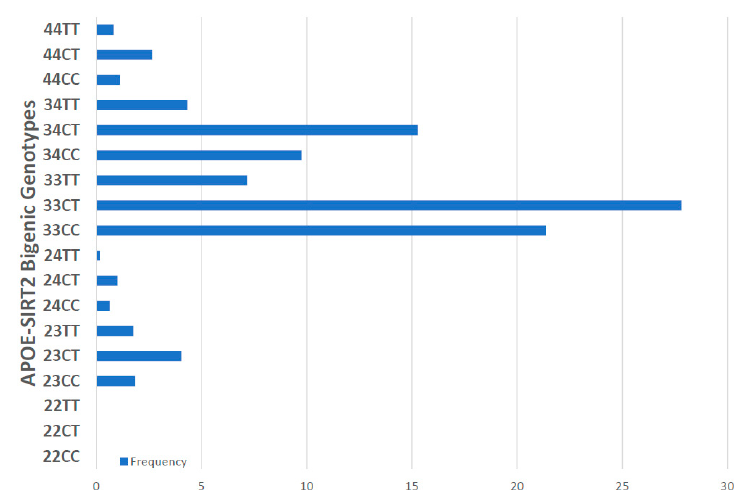
Figure 3. Frequency of APOE-SIRT2 bigenic genotypes in Alzheimer’s disease.